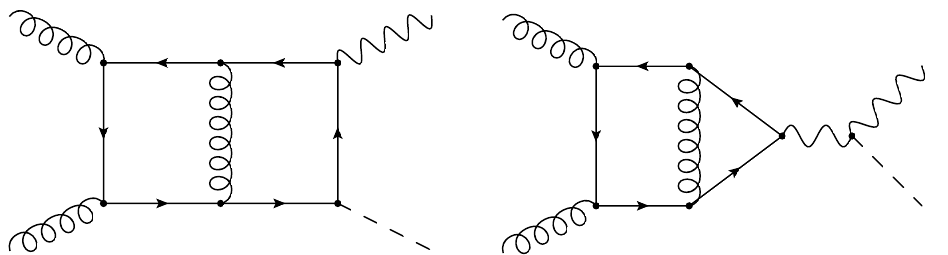
Figure 1. Representative Feynman diagrams for the virtual correction to the ggZH